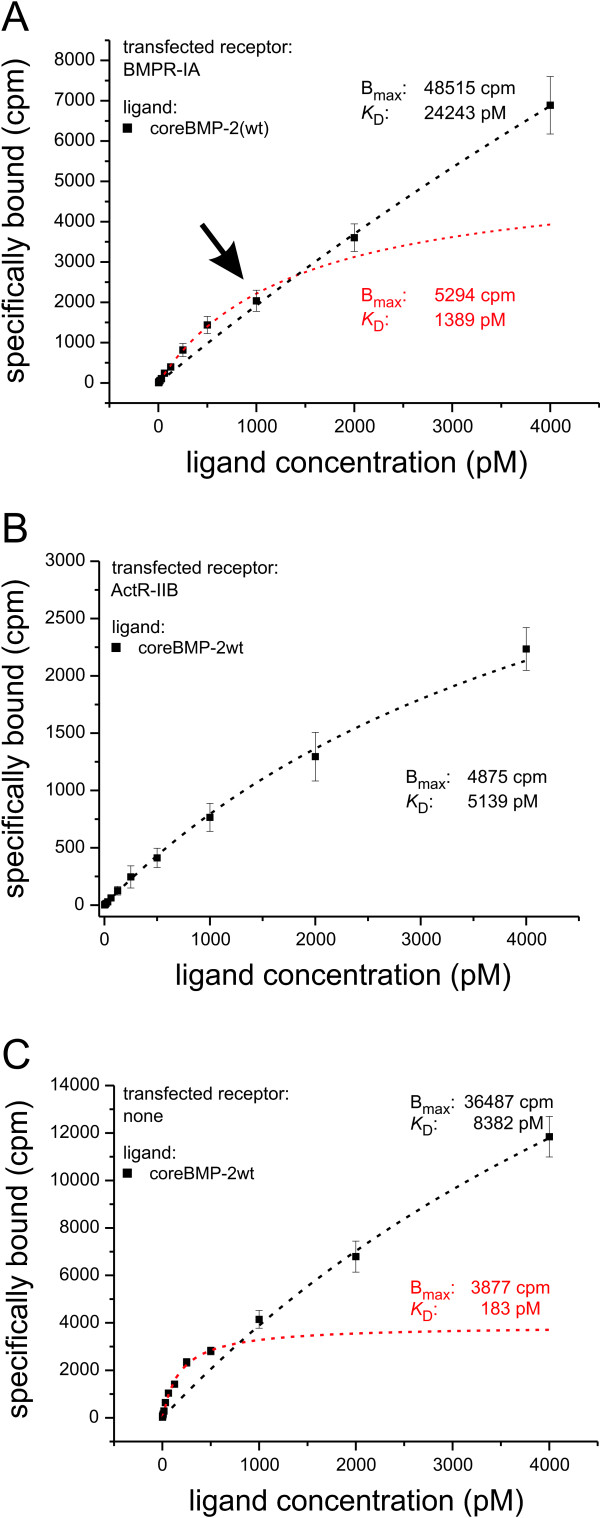
Binding of radiolabeled ligands using higher ligand concentrations. (a) Specific binding of core bone morphogenic protein (wild type) (coreBMP2wt) to BMP receptor (BMPR)-IA transfected results in a biphasic binding curve with a pronounced break (marked by arrow). Fitting the curve separately (0 to 500 pM and 1,000 to 4,000 pM) to a one-site binding model the indicated values for KD and Bmax were achieved. (b) Specific binding of coreBMP2wt to COS-7 cells transfected with activin receptor (ActR)-IIB and (c) to untransfected C2C12 cells.